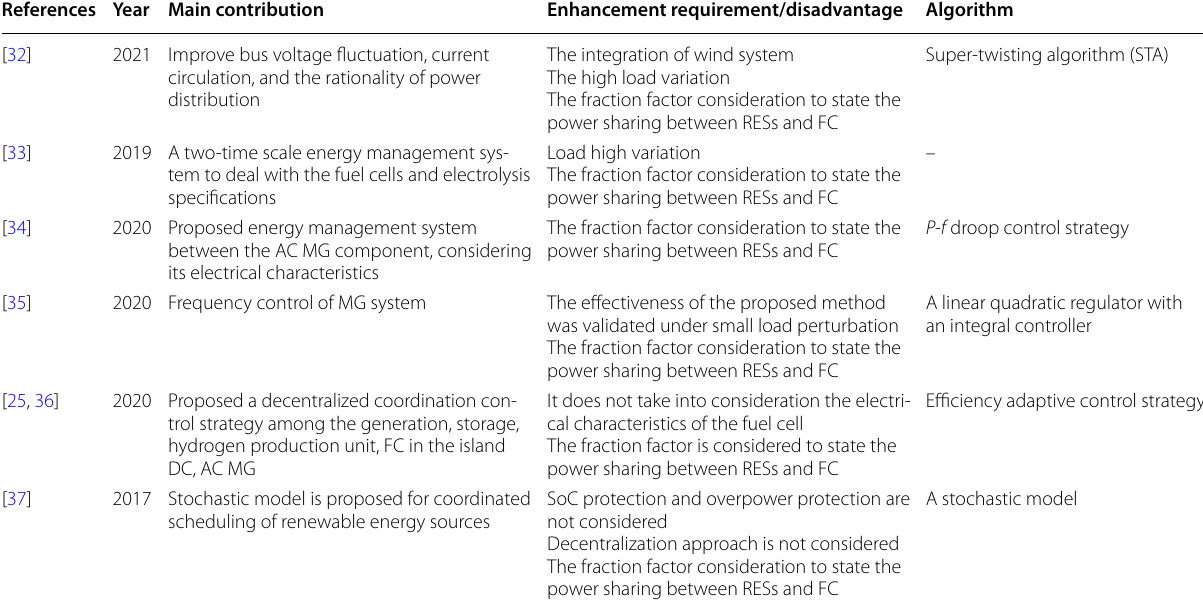
Table 1 Summary of state-of-the-art